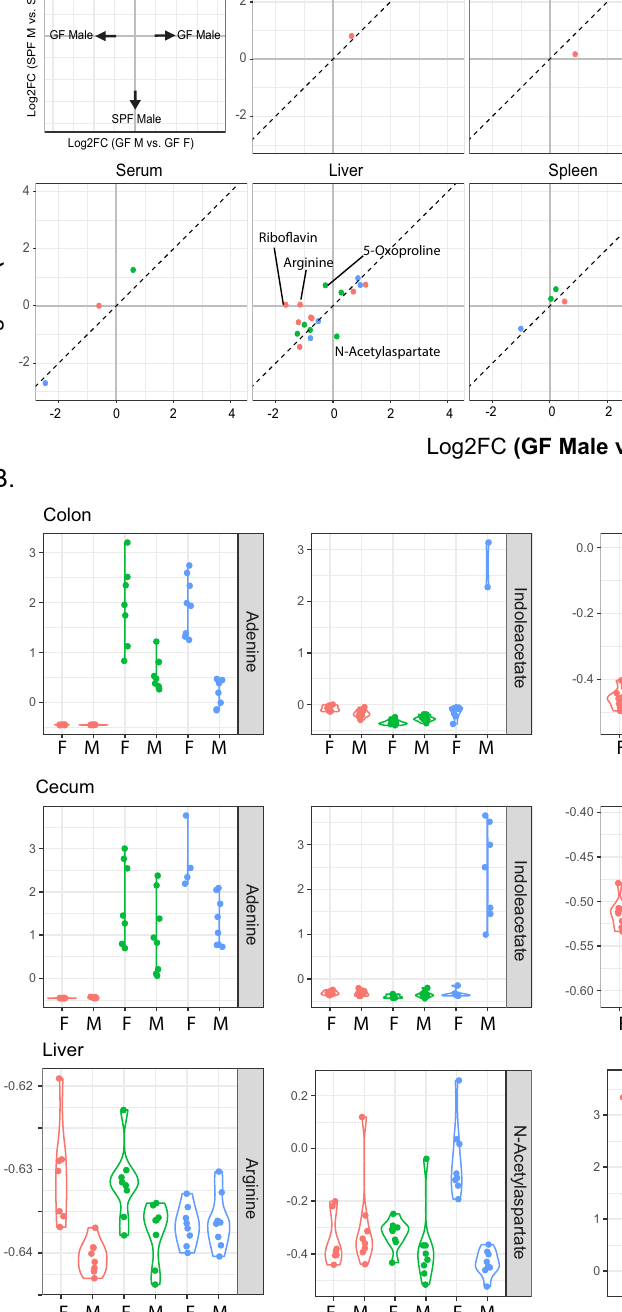
colonization in male and female mice. Data shown for GF, OMM12 and SPF colo- nizedmaleandfemalemice.Datarepresented8mice/group.GFgerm-free,OMM12 Oligo-MM12, SPF speci fi c pathogen free, F female, M male. Source data are pro- vided as a Source Data fi